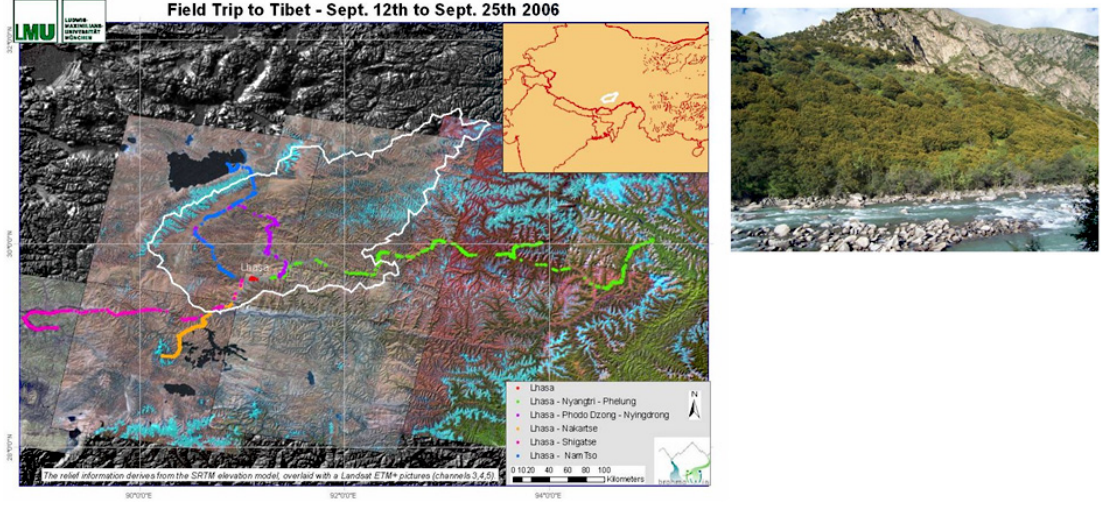
Figure 6. Left: GPS tracks for field trip around Lhasa catchment. Map compiled by M. Prasch, GPS tracklogs recorded by S. Lang. Right: Example of a georeferenced photograph. Holm oaks on the way from the Mi La Pass to Nyangtri (14.09.2006, M. Prasch).